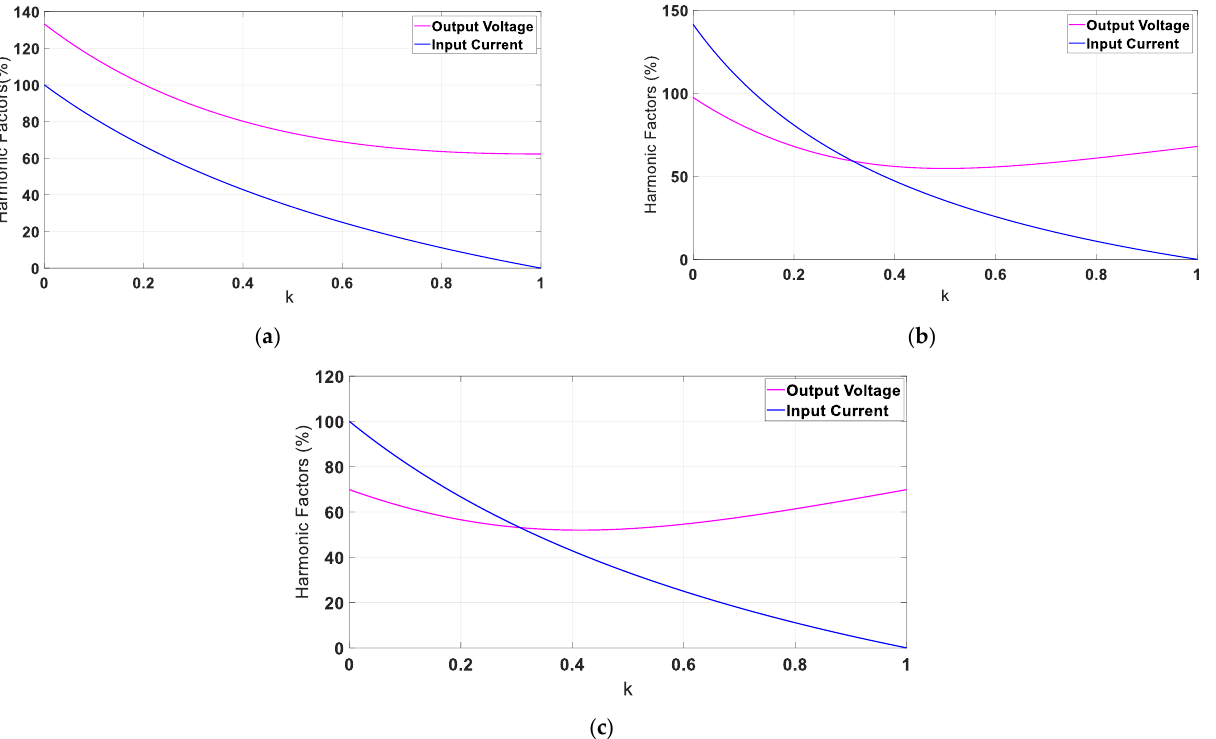
Figure 7. Harmonic factors of output voltage and input current for various output frequencies with respect to magnitude scaling factor ( k ): ( a ) one-half; ( b ) one-third; and (c ) one-fourth.